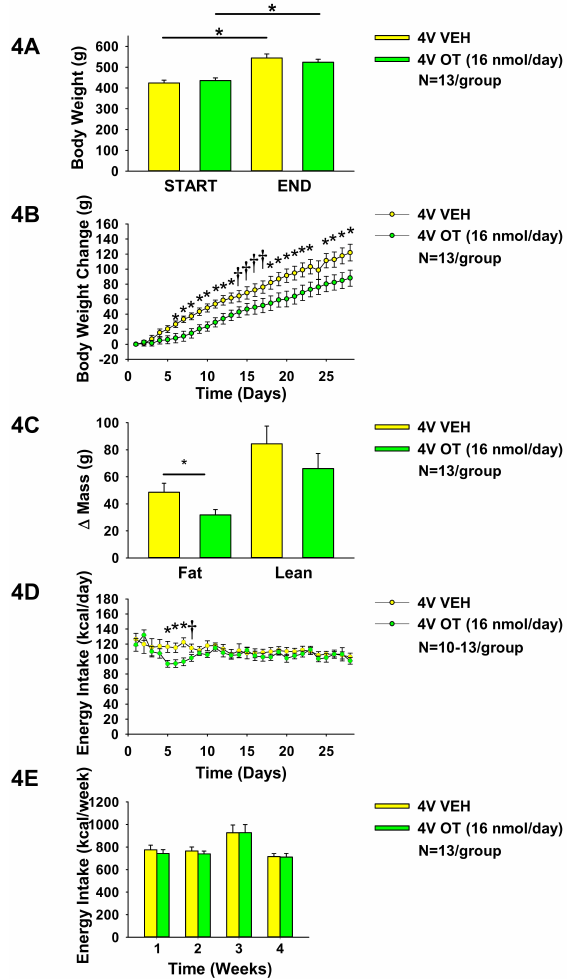
Figure 4. ( A – E ). Effects of chronic 4V OT infusions (16 nmol/day) on food intake, body weight gain, and body composition in male HFD-fed CD ® IGS rats. Ad libitum-fed rats were placed on HFD [60% kcal from fat (Research Diets, Inc., D12492); N = 13/group] at onset of continuous 4V infusions of vehicle or OT (16 nmol/day). ( A ), Body weight before and after chronic 4V treatment in animals maintained on the HFD. ( B ), Cumulative change in body weight throughout course of chronic 4V treatment in animals maintained on the HFD. ( C ), Change in fat mass and lean mass before and after chronic 4V treatment in animals maintained on HFD. ( D ), Change in daily energy intake (kcal/day) in animals maintained on HFD. ( E ), Cumulative change in weekly energy intake (kcal/week) in animals maintained on HFD. Data are expressed as mean ± SEM. * P < 0.05 or † 0.05 < P < 0.1 OT vs.